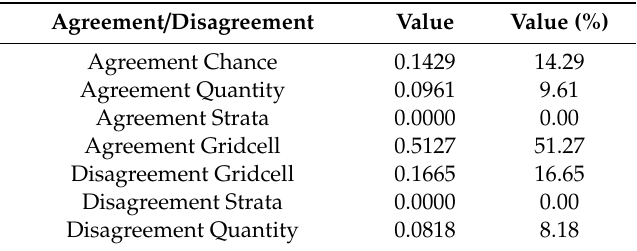
Table 4. Results of validation analysis of two images (agreement / disagreement components values).